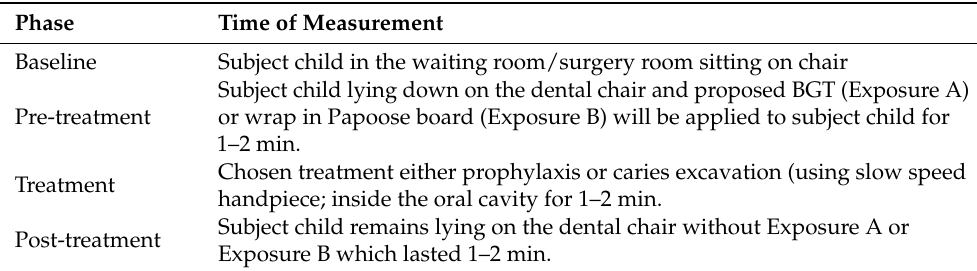
Table 1. Phases of time measurement of physiological vital signs.